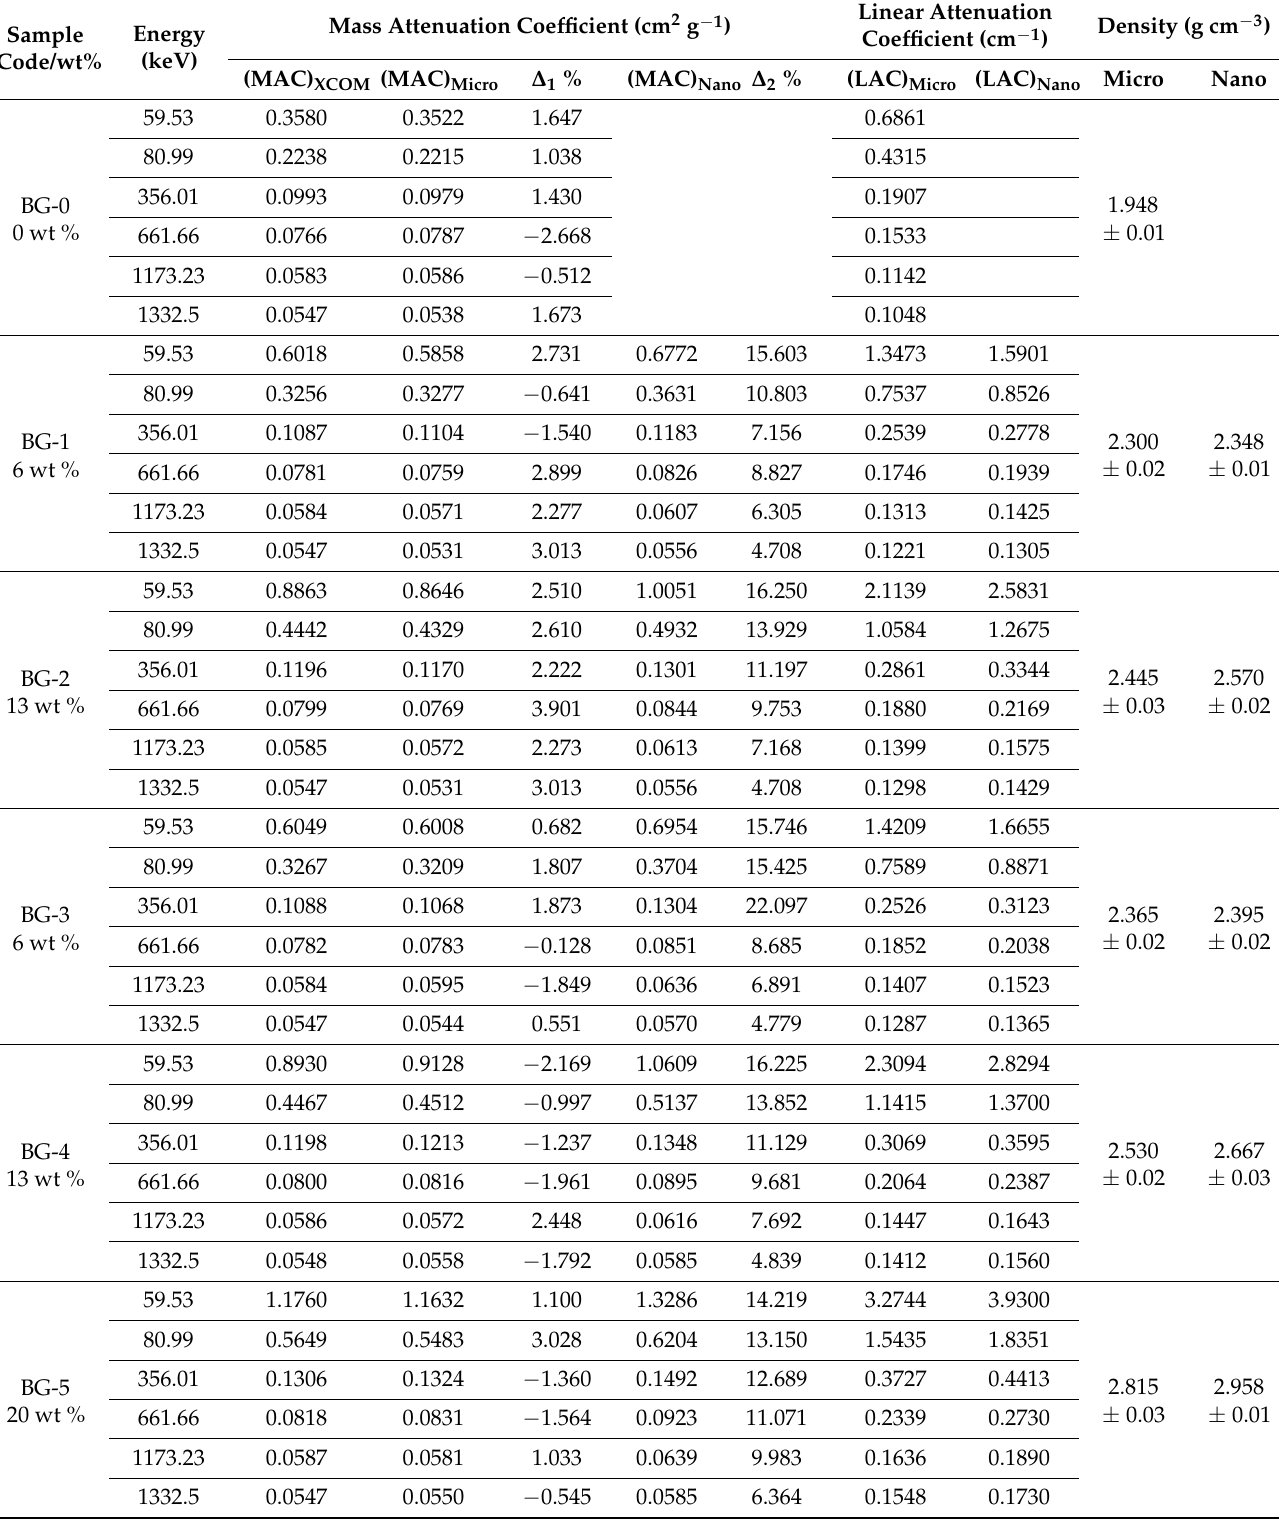
Table 3. Measured values and theoretical values using the XCOM program of mass attenuation coefficients, linear attenuation coefficients, relative deviation, and density of pure